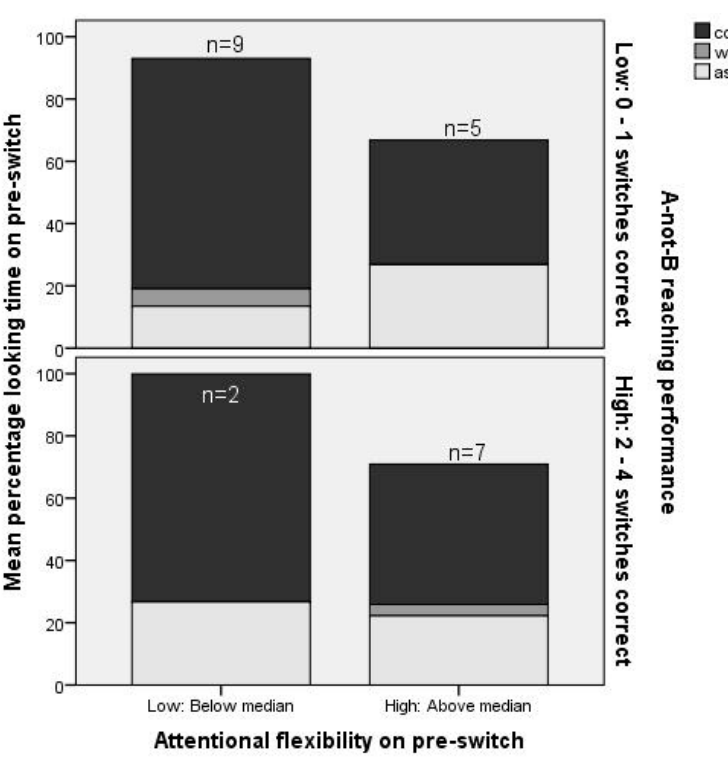
Figure 6. Attentional flexibility on the pre-switch trial in relation to the total number of switches correct (reaching response, dichotomized for presentation purposes) on the A-not-B task.